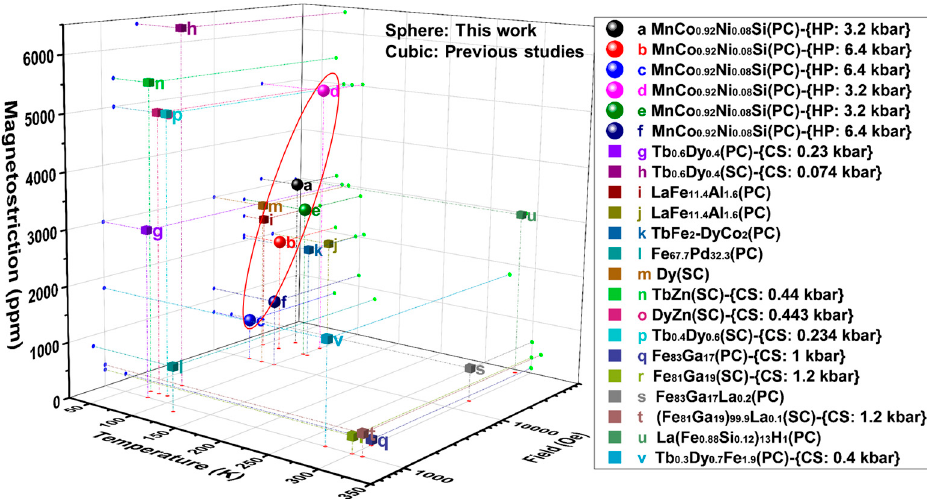
Figure 4. Comparison of magnetostrictive values ( λ ) between the present alloy and some other magnetostrictive materials under single/multiple external fields: g [33], h [34], i [35], j [35], k [32], l [22], m [19], n [36], o [37], p [38], q [39], r [3,40], s [41,42], t [3], u [4], v [43]. (The abbreviations PC, SC, HP, and CS denote polycrystalline, single crystalline, hydrostatic pressure, and compress stress).